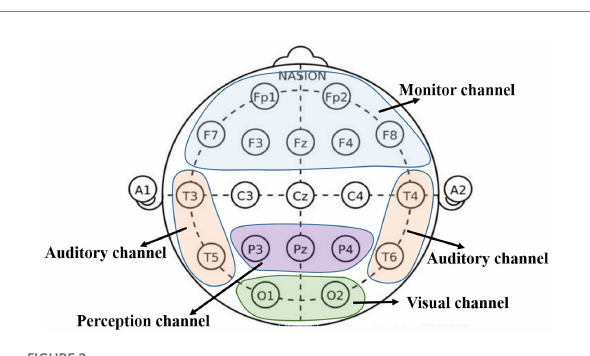
FIGURE 2 Electrode position and different functional channels diagram.